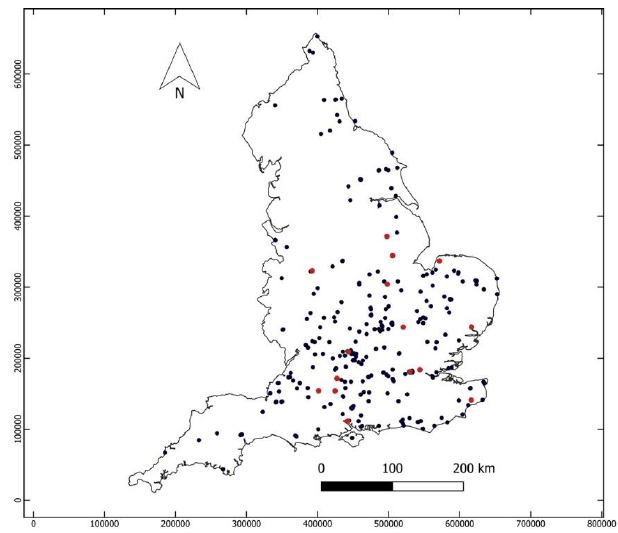
Figure 1. Location of all sites included in the dataset. Full details can be found from the Archaeological Data Service [33]. Targeted sites are shown in red. Table 2. Targeted sites showing the phases of occupation and the number of cattle foot bones (metapodials and phalanges) recorded. Site